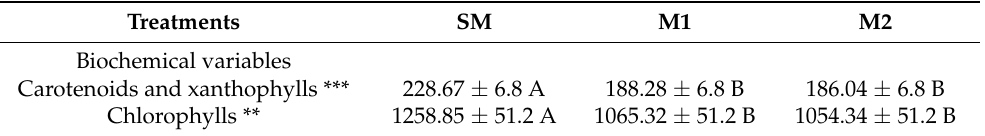
Table 2. Mean and standard deviation for thebiochemical variables: total contents of chlorophylls ( µ g/mL), carotenoids and xanthophylls ( µ g/gMF). Stars indicate the significance level.